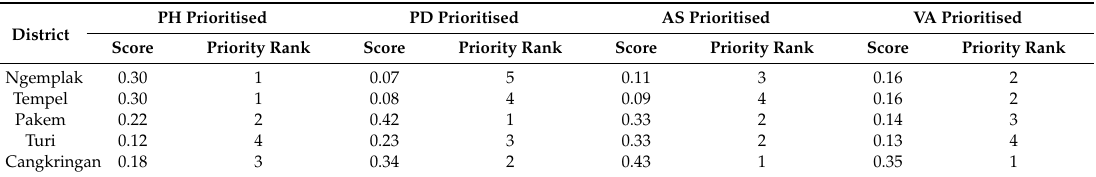
Table 3. Staging scenarios calculation and ranking.